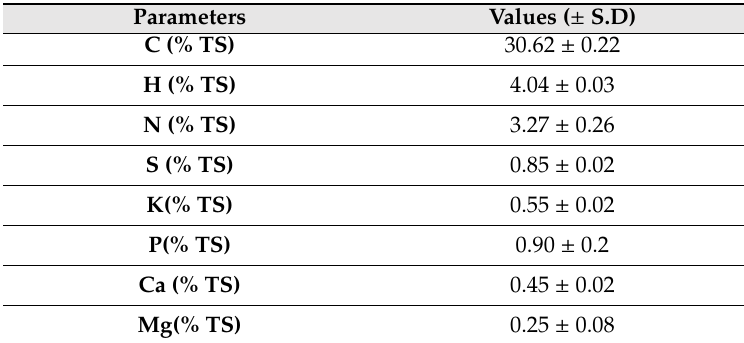
Table 3. Main chemical properties of the microalgae cultivated and harvested in this